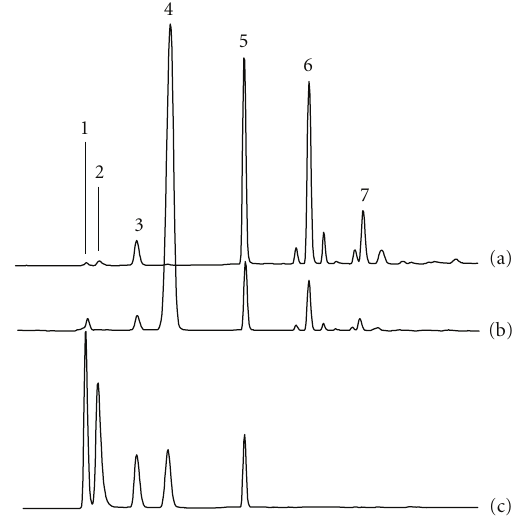
Figure 5: Chromatographic profiles of (a) symbiotic milk contain- ing Actilight as prebiotic scFOS; (b) synthetic mixture of glucose, fructose, sucrose, lactose, and 1-kestose (GF3); (c) Actilight. Chro- matographic conditions as reported in the text. Peak